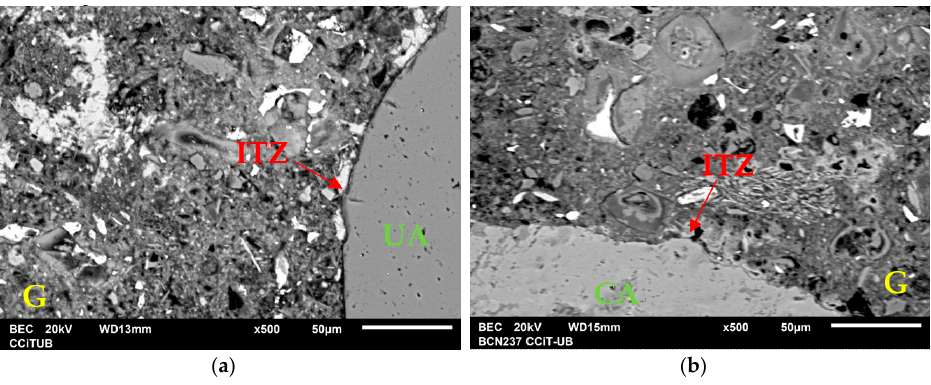
Figure 6. ( a ) UM (0% of CA); and ( b ) RCM10 (10% of CA).